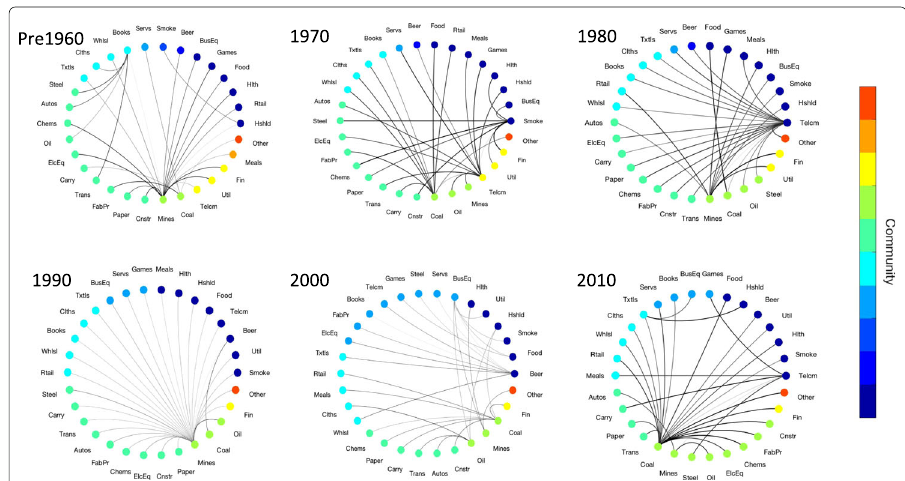
Fig. 2 SnapshotsofCommunityAssignmentsfromtheData. This figure plots snapshots of industry communities every 10 years for the 1960 to 2014 sample. Note that the community structure was constant before 1960. Lines indicate a pairwise correlation of industry returns greater than 0.7. Darker lines indicate a stronger connection. By 1970 the communities begin to change modestly, with increasing movement through the 80s, 90s, and 00s